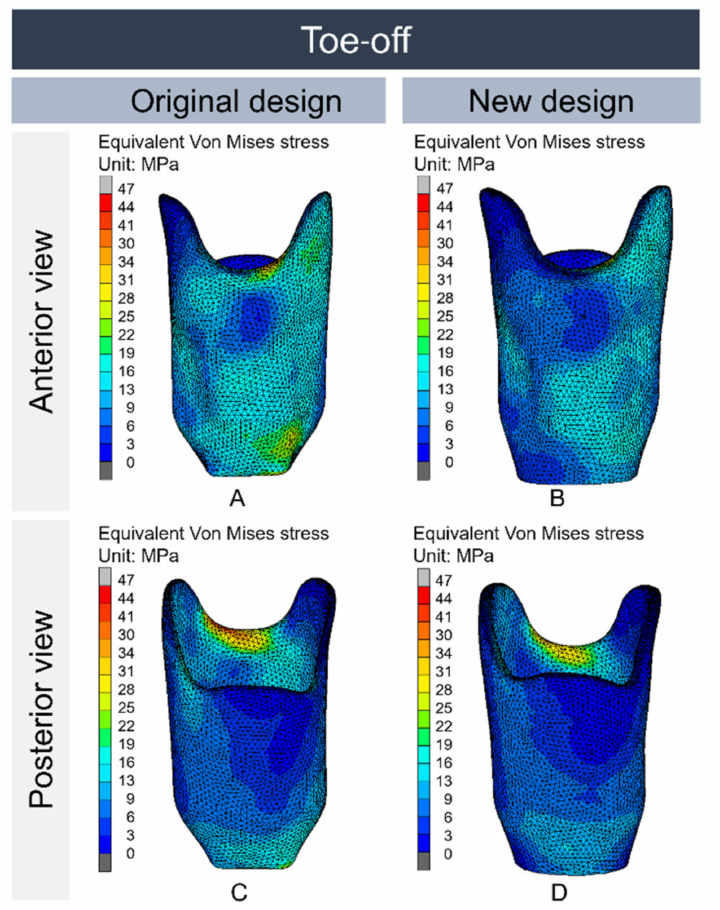
Figure 6. Comparison of the original socket design in the toe-off phase (wall thickness of 4 mm throughout the entire socket) with the new socket design (wall thickness of 4 mm with an increase to 7 mm at the trimline). The new socket design also had a round shape at the bottom instead of a square bottom to reduce stress concentrations in that area. ( A ) Original design in the front view, ( B ) New design in the front view, ( C ) Original design in the rear view, ( D ) New design in rear